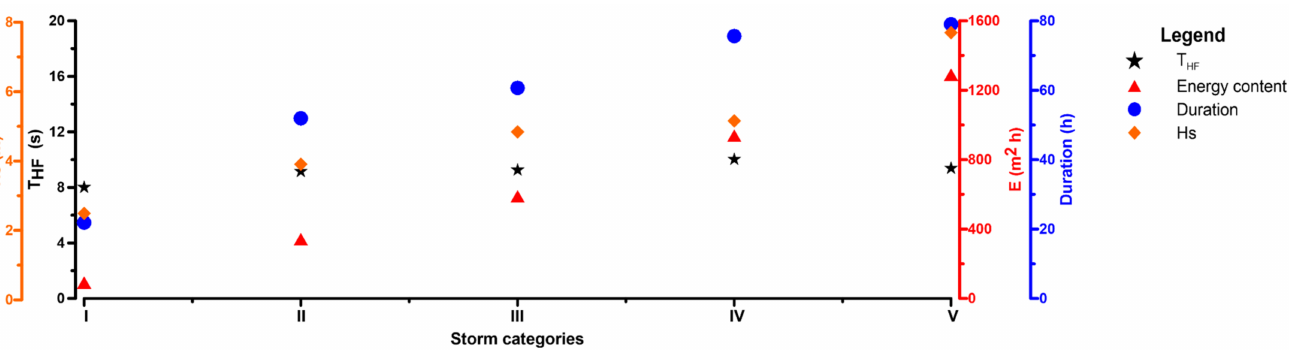
Figure 5. Class-averaged values of wave storms retrieved from RC5 of SeaSonde network in the GoN.